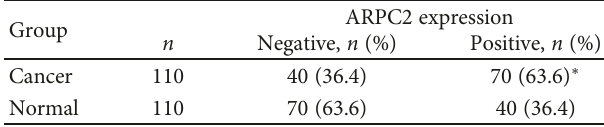
Table 1: Expression of ARPC2 in gastric cancer and normal